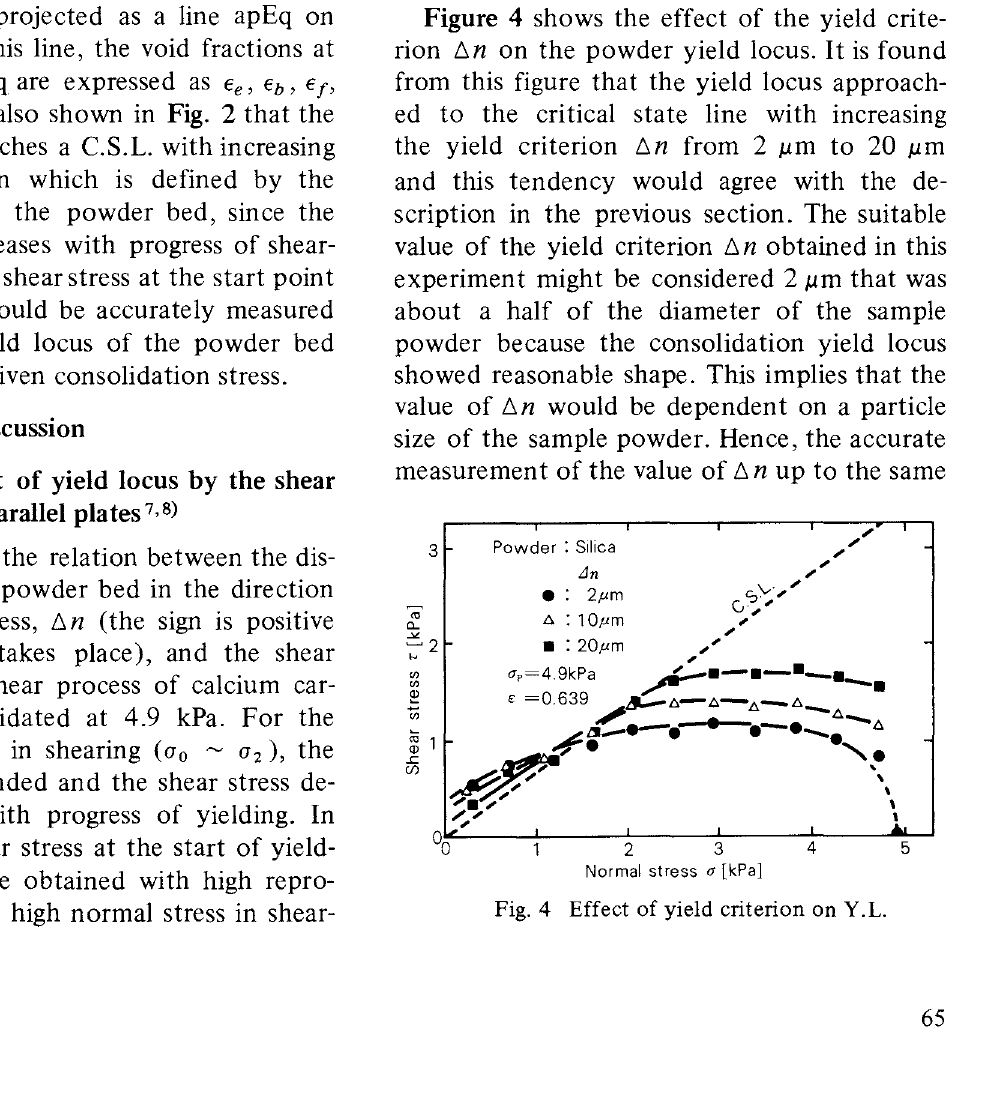
Fig. 4 Effect of yield criterion on